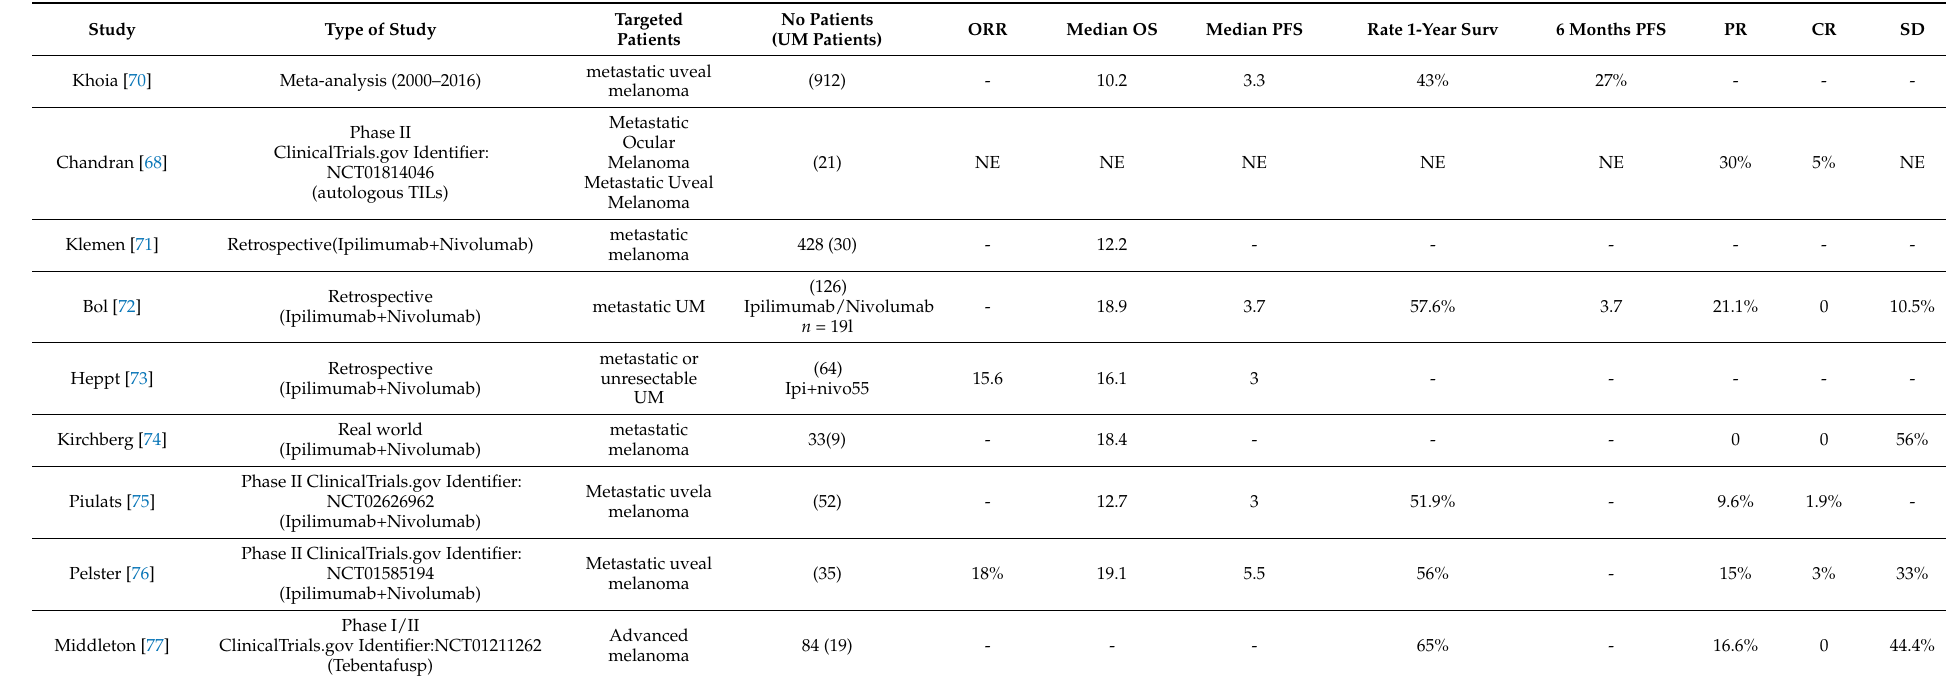
Table 1. Immunotherapy in UM: published